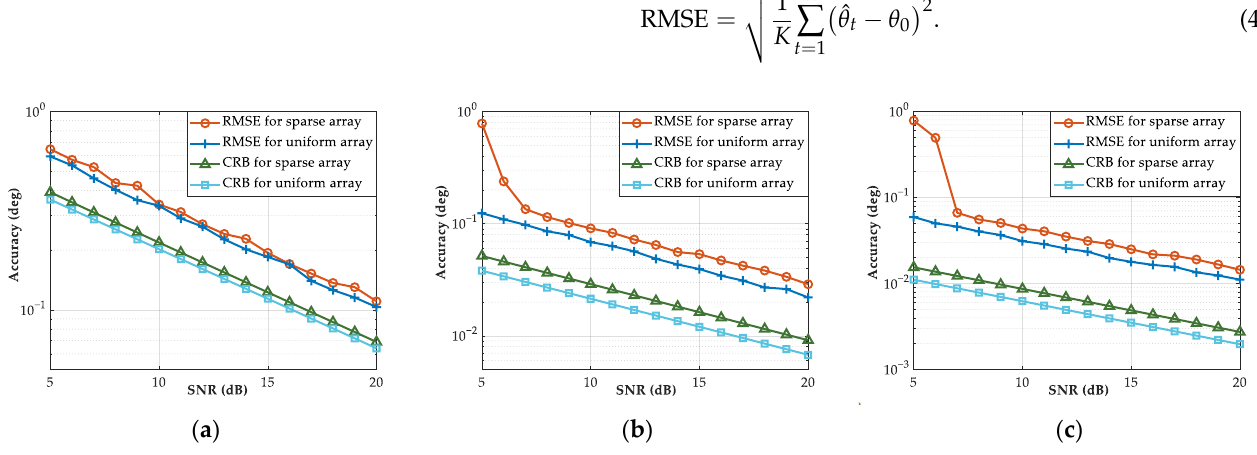
Figure 10. The comparison results of angular measurement accuracy for multi-subarray: ( a ) SRS detection type; ( b ) MRS detection type; ( c ) LRS detection type.